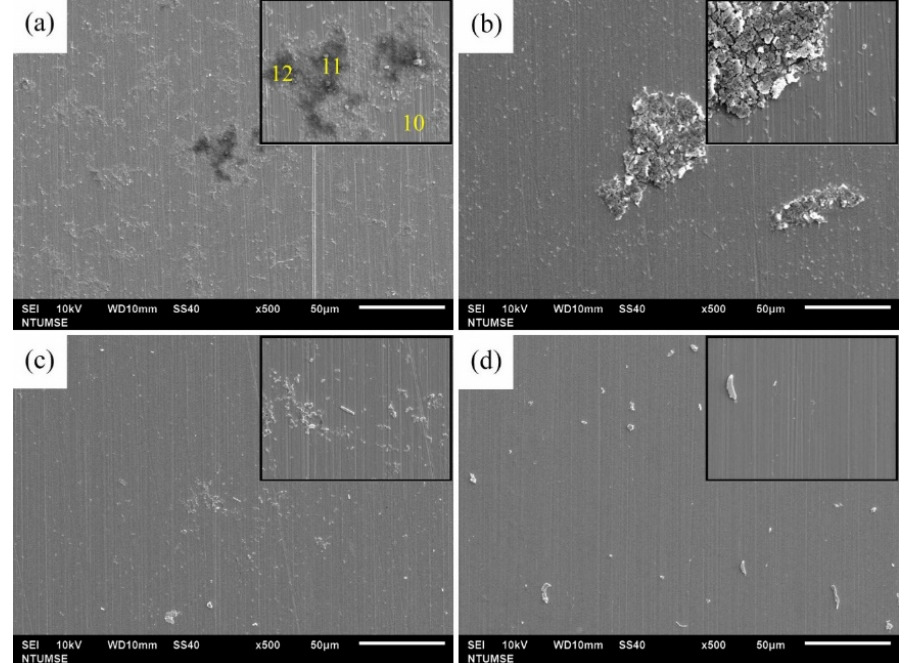
Figure 10. SEM images of 304 SS surface after 336 h of exposure in ( a ) the Zuoying inocula medium without treatment, ( b ) TB, ( c ) 3TB, and ( d ) 5TB, presenting enlargements of areas with biofilm formation. Table 2. Elemental composition ratio on the surfaces of 304 SS corresponding to the Tamsui and Zuoying inocula.